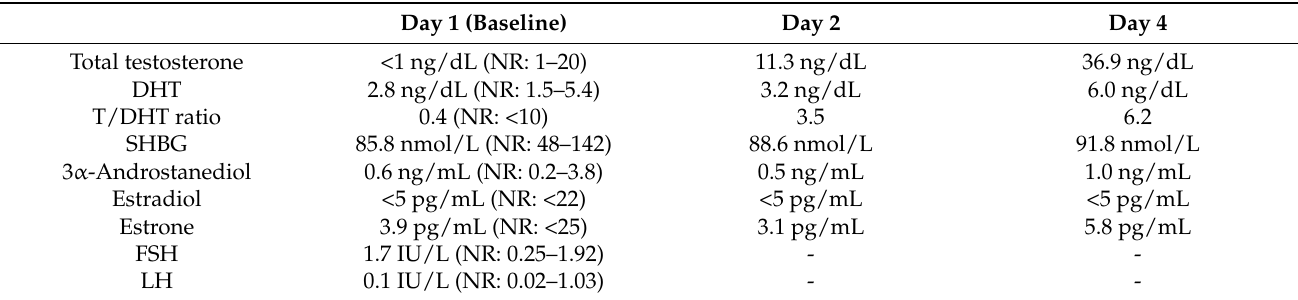
Table 1. Baseline and hCG-stimulated plasma hormone levels.